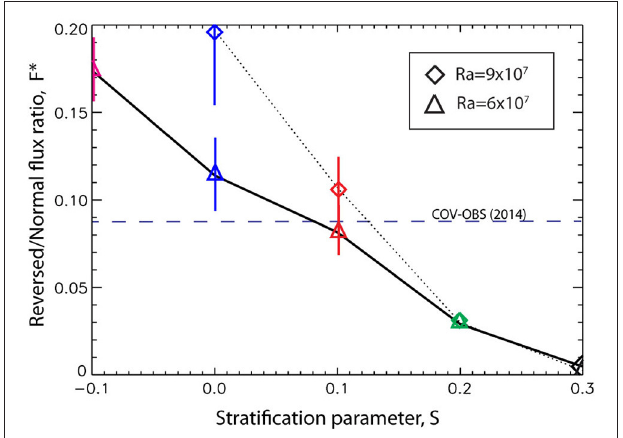
FIGURE 6 | Ratios of reversed to normal flux contributions to the axial dipole F * vs. stratification parameter S from numerical dynamos (symbols), compared to F * from the COV-OBS geomagnetic field model on the core-mantle boundary at epoch 2014 (dashed line). Error bars denote one standard deviation of dynamo snapshots.